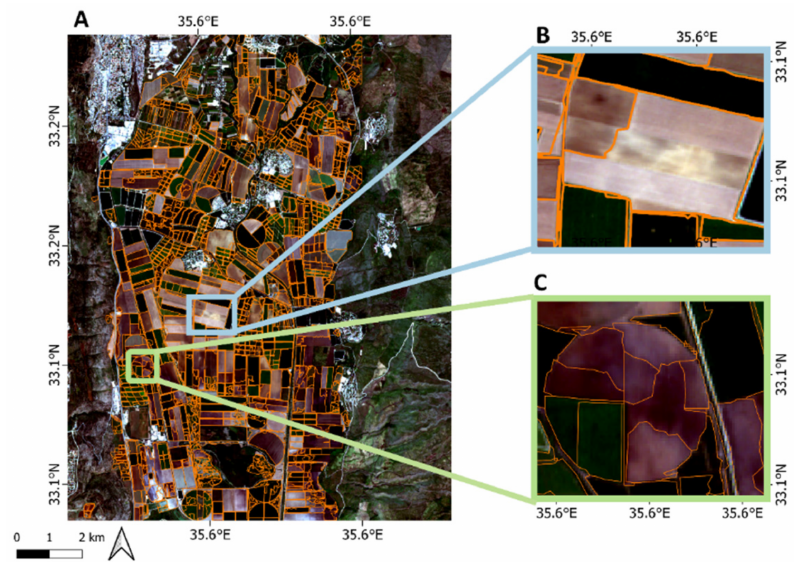
Figure 6. Segmentation output with mean shift algorithm using the green, red, and NIR bands as input and high emphasis on the spectral and spatial characteristics. ( A ) Segmented image of part of the study area. ( B ) Under segmentation problem. ( C ) Over segmentation